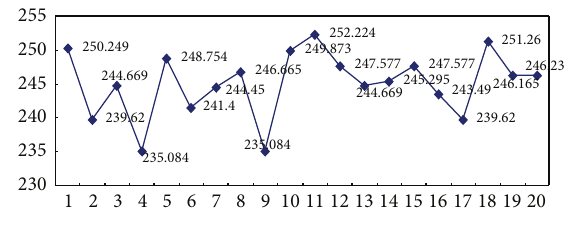
Figure 5: 20 times calculation